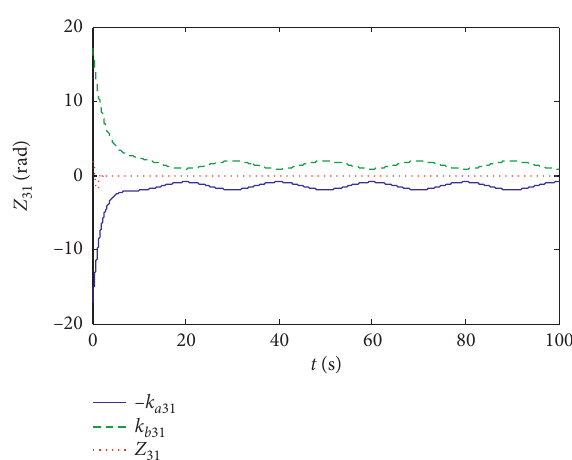
Figure 11: Constraint effect of Z